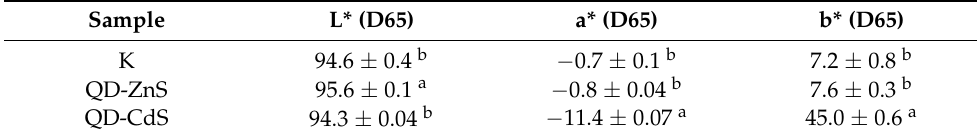
Table 1. Color parameters of the foils.